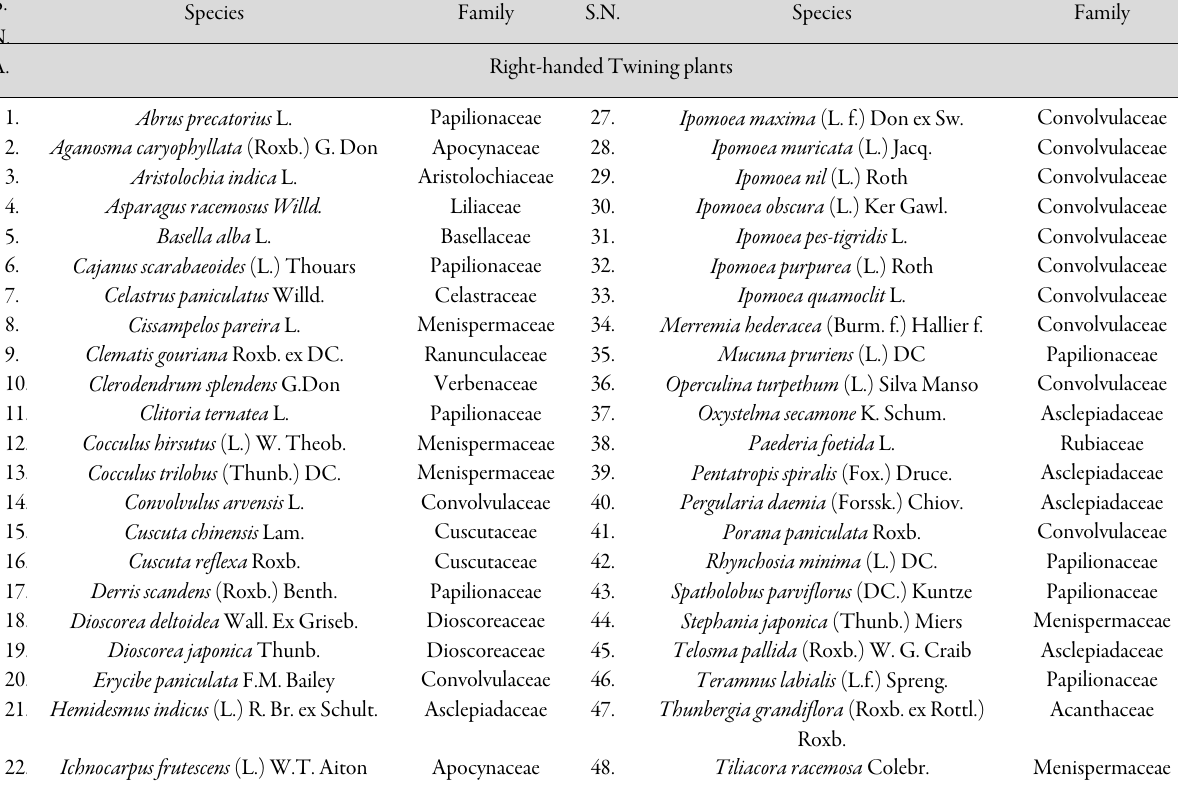
SupplementaryTtable 3. List of climbing plant species showing right-handed and left-handed twining pattern across the terrestrial vegetation of north-eastern Uttar